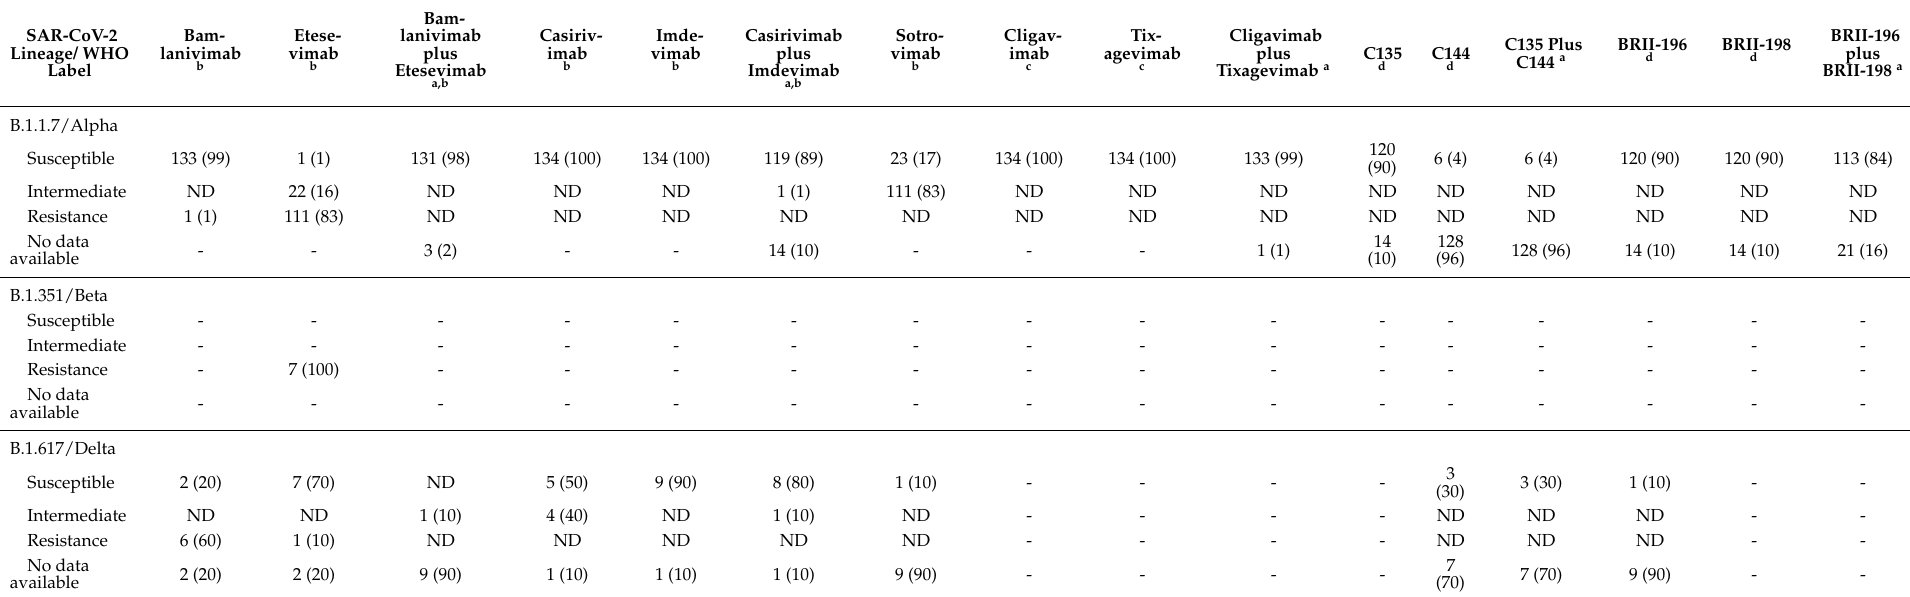
Table 2. Susceptibility rate of SARS-CoV-2 variants to SARS-CoV-2 monoclonal